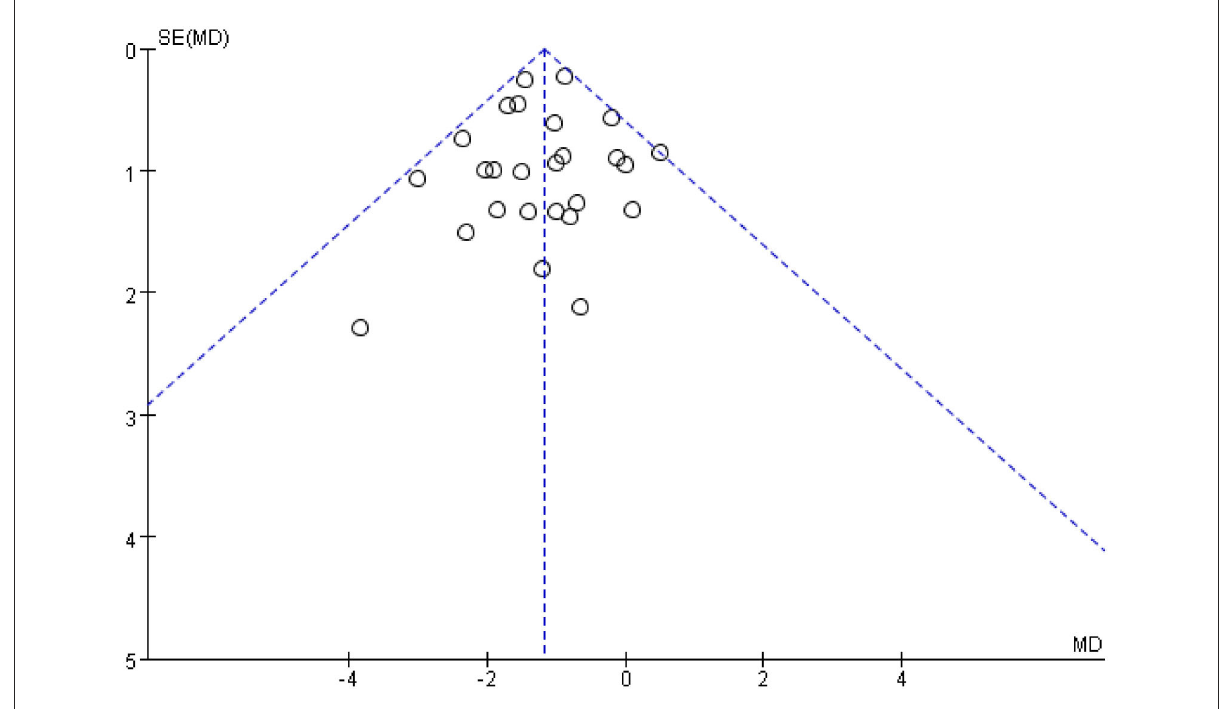
FIGURE6 After removing three studies, the symmetrical funnel plot was obtained.